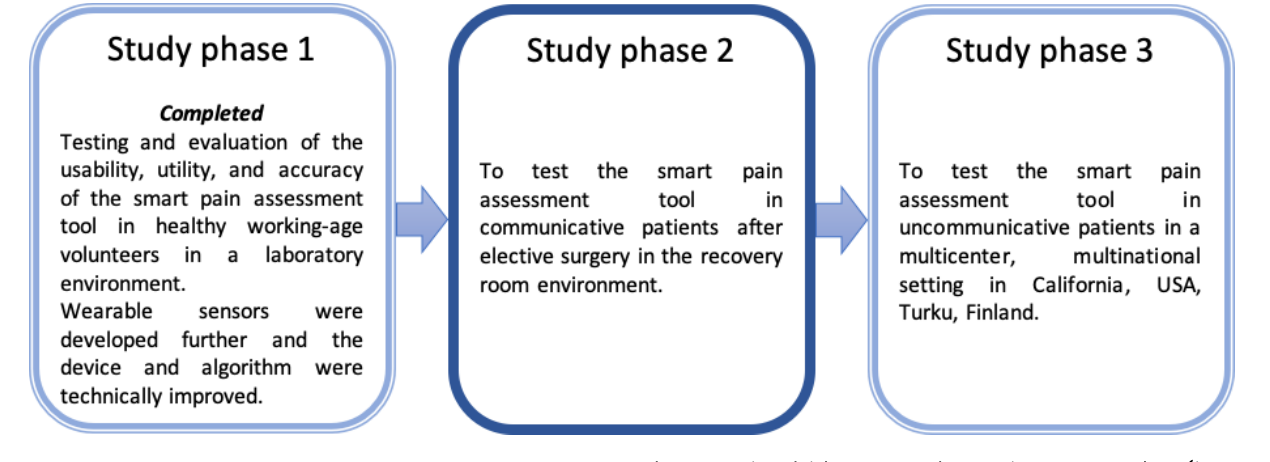
Figure 1. Study design for the development of a pain assessment